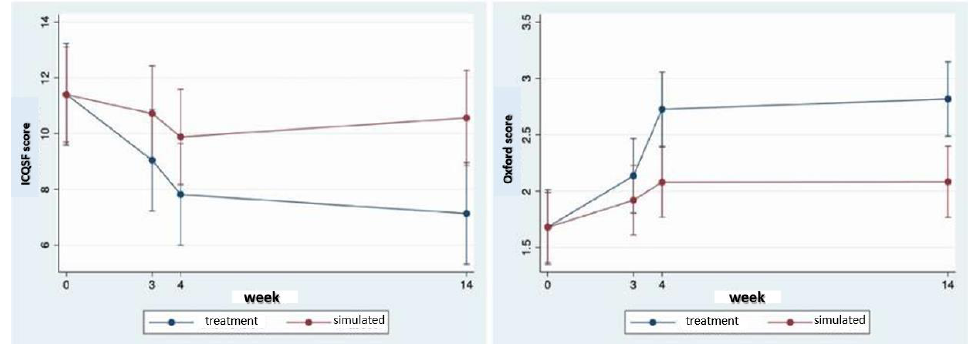
Figure 2. ICQSF and Oxford questionnaire scores at weeks 3, 4, and 14 of follow-up.